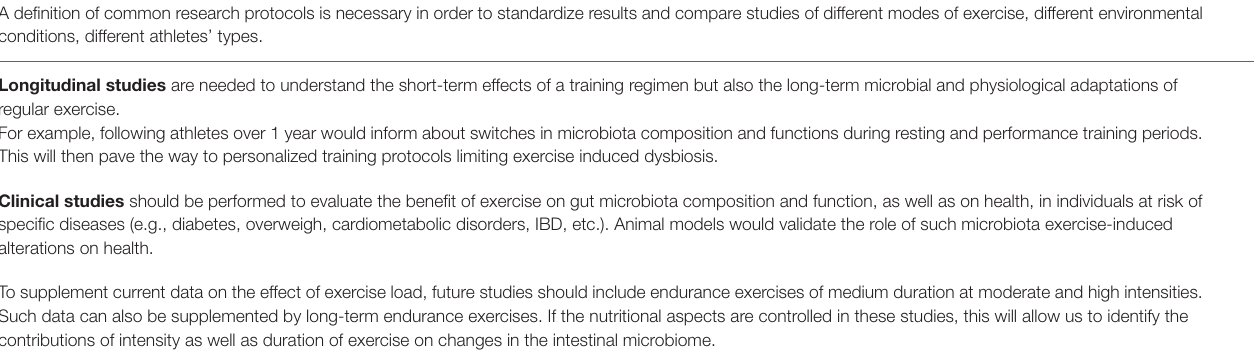
contributions of intensity as well as duration of exercise on changes in the intestinal